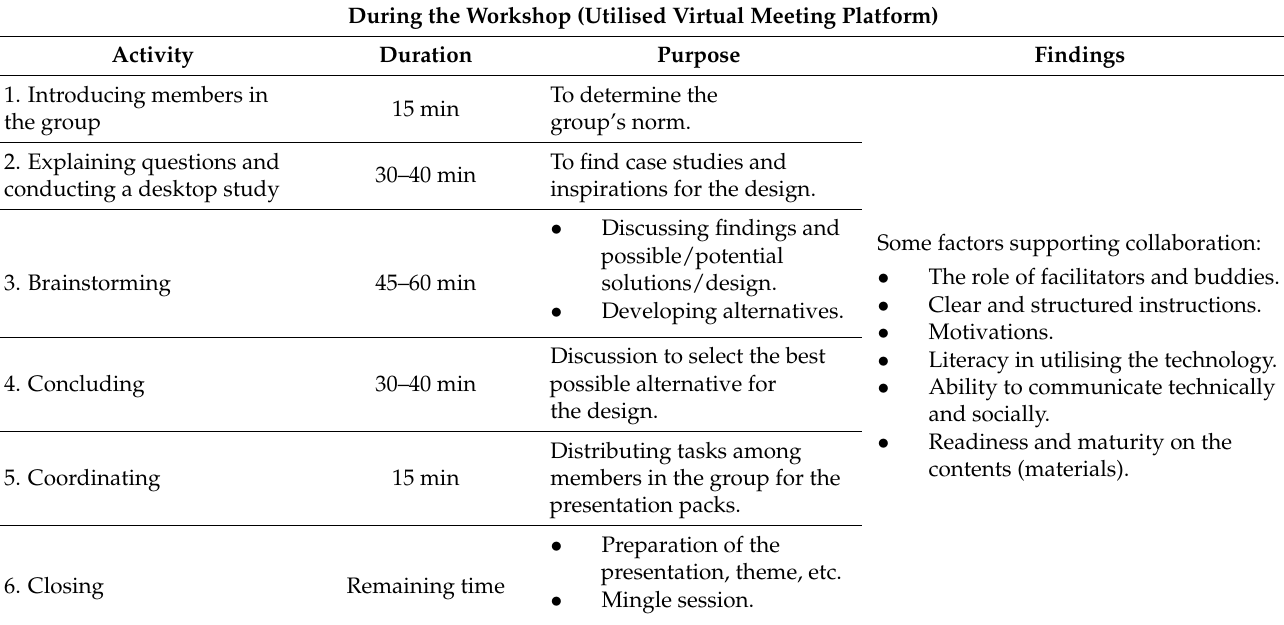
Table 7. Research findings and details of